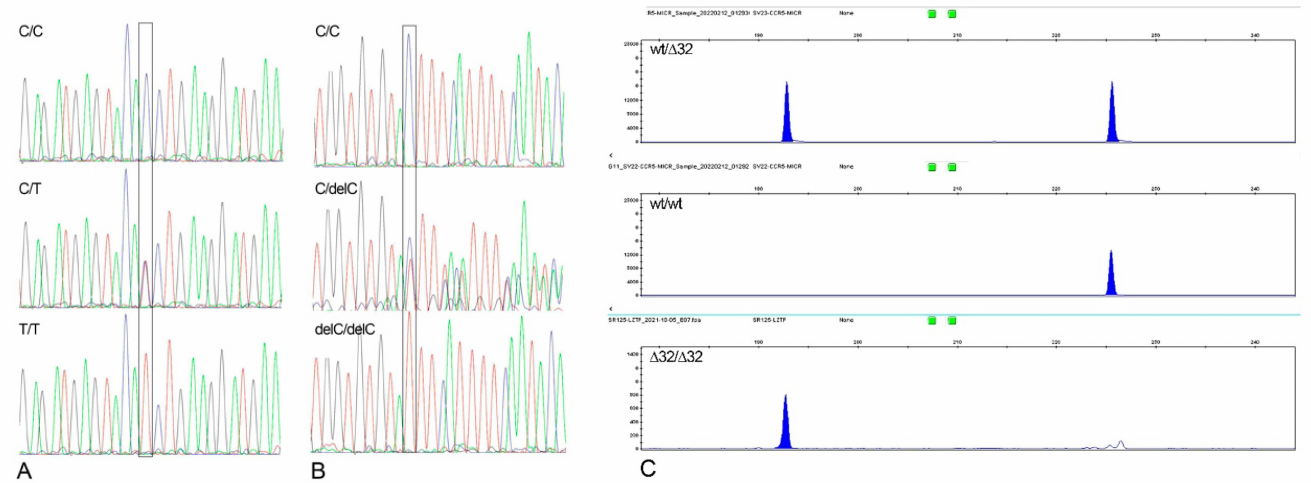
Figure 5. Visualization of the genotypes for the rs12329760, rs35074065, and rs333 polymorphisms. ( A ) Sanger sequencing electropherograms for the rs12329760 polymorphism of the TMPRSS2 gene. ( B ) Sanger sequencing electropherograms for the rs35074065 polymorphism of the TMPRSS2 gene. ( C ) Gene Mapper visualization of the rs333 polymorphism of the CCR5 gene. All the genotypes are indicated.